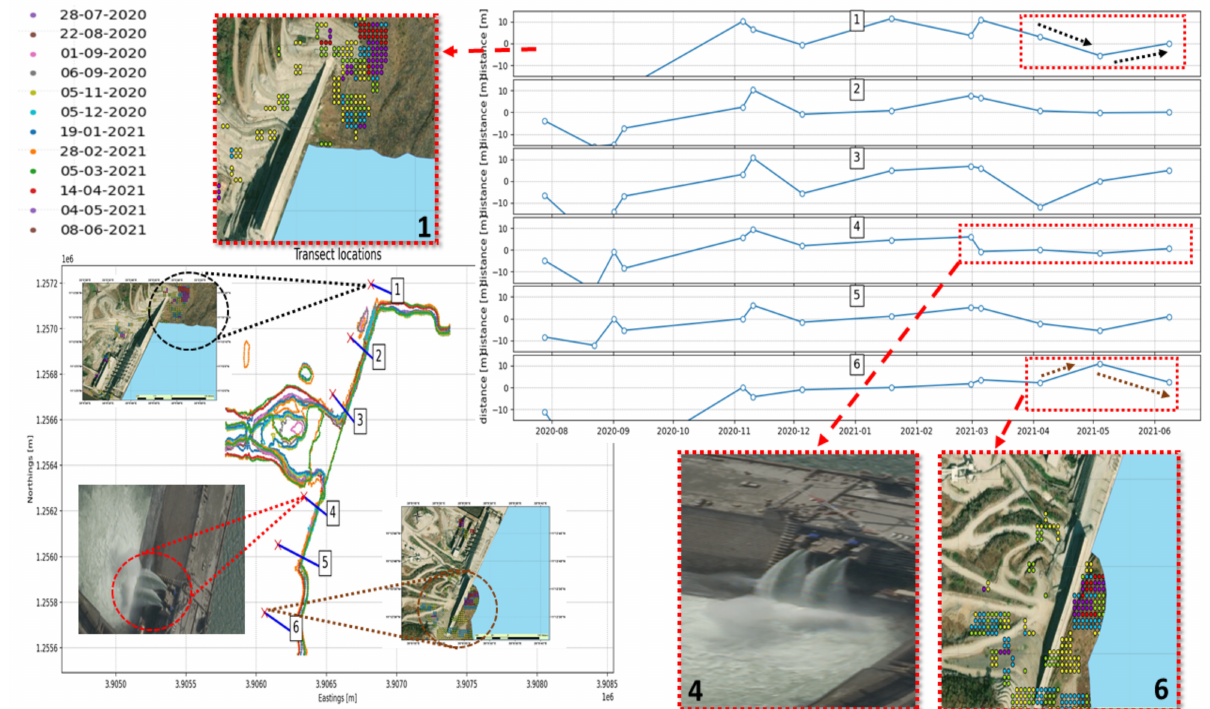
Figure 14. CoastSat analysis over the GERD’s Main Dam showing the change in water edge along different locations identified from 1 to 6 following same cross-sections presented in Figure